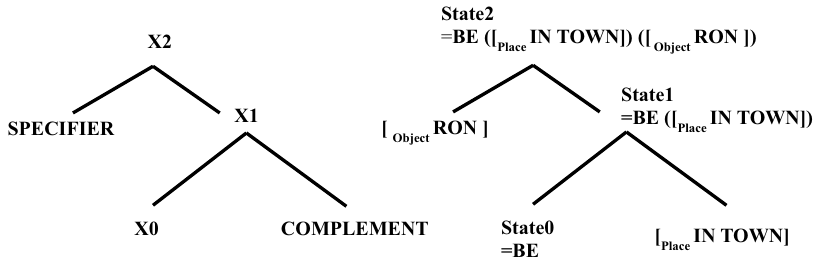
Figure 1: The parallels between an X - bar structure and a conceptual structure ( CS )